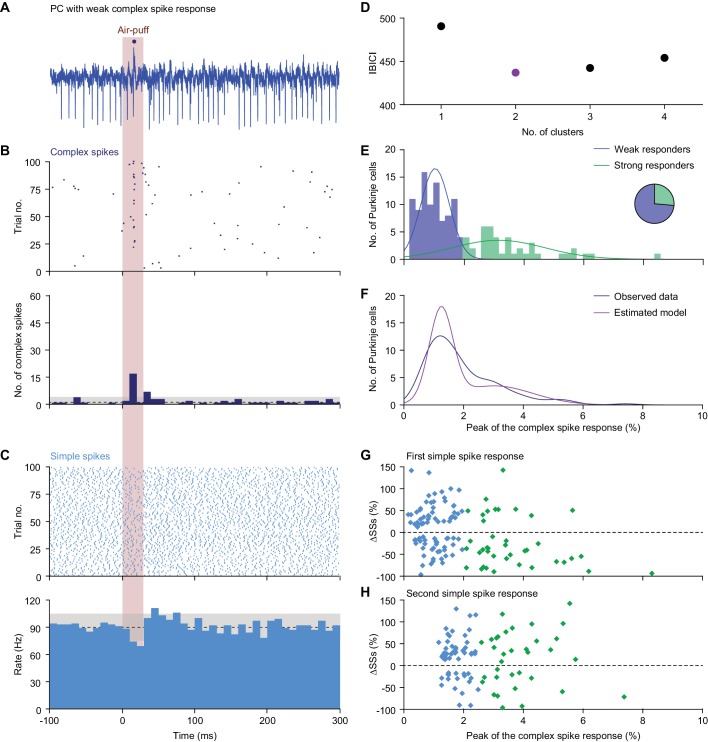
Diversity in Purkinje cell responses.(A) Single trial of a PC showing a relatively weak complex spike response to air-puff stimulation of the ipsilateral whisker pad. The dark blue dot indicates a complex spike. (B) Raster plot and peri-stimulus time histogram (PSTH) of the complex spikes of the same neuron as in (A). Note that although the initial response is relatively weak, being present only in about 15% of the trials, this is still much more than could be expected based on the frequency during the inter-trial intervals. The dashed line indicates the average complex spike rate in between trials with the grey area representing ±3 s.d.. (C) The same for the simple spike response. This PC has a bimodal simple spike response, first a decrease and then an increase in simple spike activity. (D) Based upon the complex spike response probability, defined as the peak of the complex spike response in the convolved PSTH, clustering the PCs into two clusters yielded the smallest Bayesian information criterion (BIC) value. (E) The majority (66%) of the PCs could be classified as ‘weak responders’ and the minority (34%) as ‘strong responders’ (see pie diagram). This classification was obtained using a univariate Gaussian mixture model (blue and green lines, representing the two clusters). (F) Comparison of the distribution of the observed complex spike responses and that expected by our model. (G) The strength of the complex spike response and the first peak or trough (cf. panel C) in the simple spike (SS) response were not significantly correlated. Only the PCs with a very strong complex response tended to have a decrease in the simple spike response. (H) The same applied for the second extremum of the simple spike response. For this later phase, the complex spike and the simple spike responses were even less correlated.